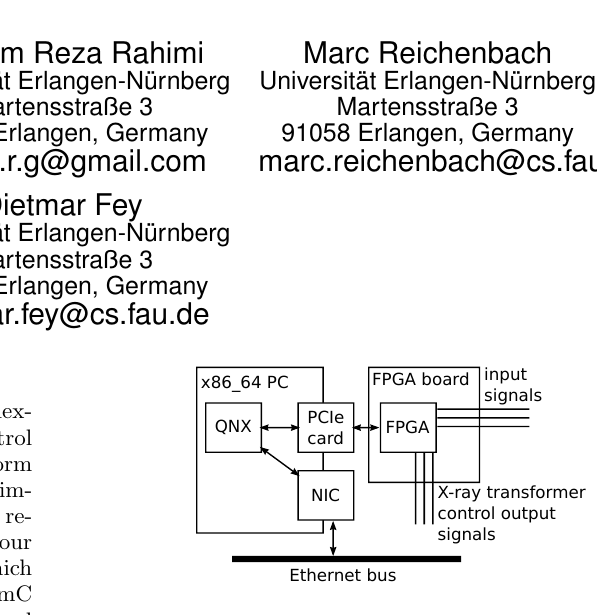
Figure 1: X-ray control unit architecture